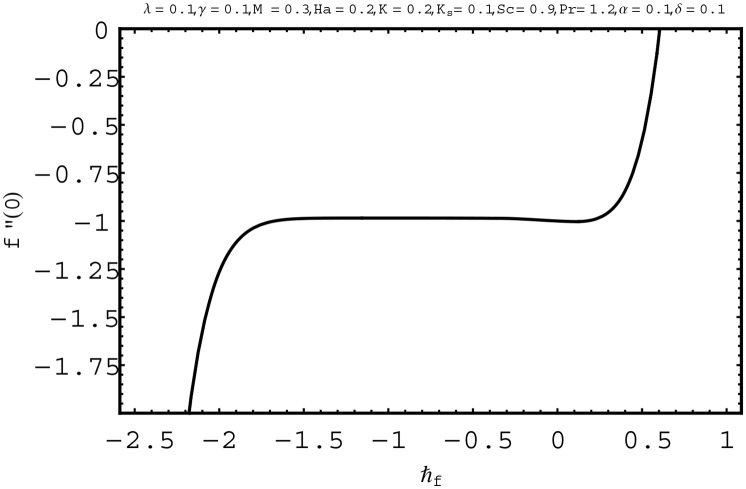
ℏ− curve for f(η).